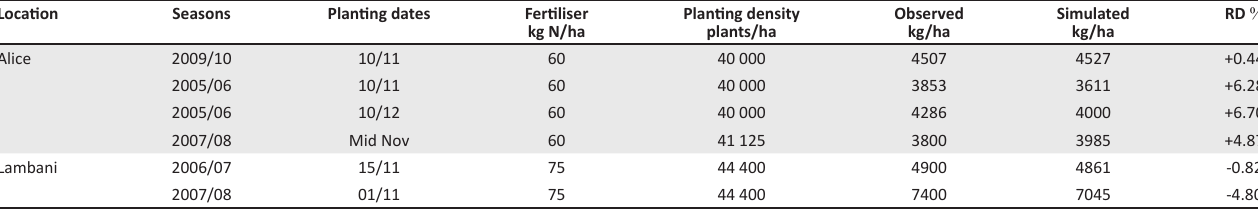
TABLE 1: Simulated and observed yields per season and management conditions. Location Seasons Planting dates Fertiliser